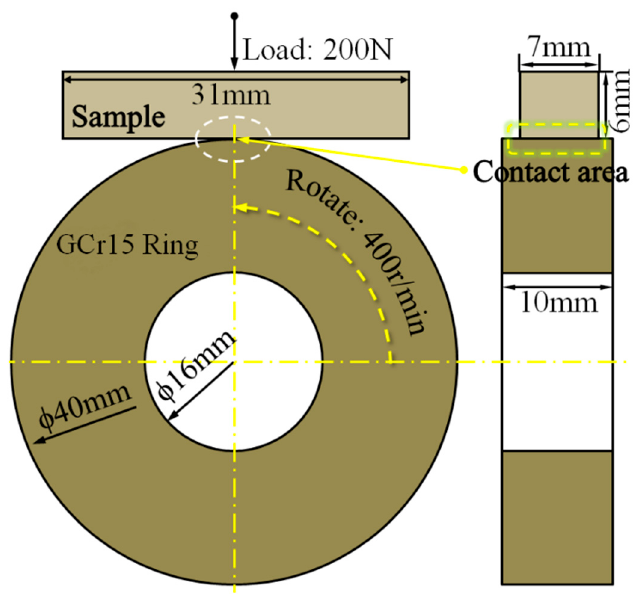
Figure 2. Schematic diagram of friction wear test.